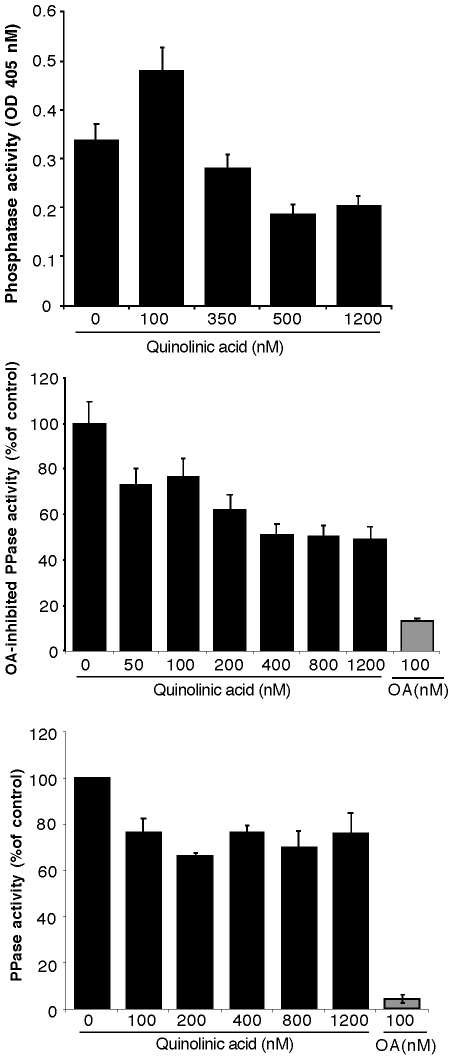
QA treatment reduces total phosphatase and PP2A activity in cultured neurons:Neuronal cultures were treated with the concentrations of QA shown, for 72 hours. Cells were lysed in the phosphatase activity buffer (50 mM Tris, pH 7.5, 150 mM NaCl, 1% NP-40, 1 mM PMSF, 1 mM Benzamidine, 10 mM β-mercaptoethanol (βME), 2 µg/ml aprotinin, 2 µg/ml pepstatin and5 µg/ml leupeptin. A: Total phosphatase activity was determined using pNPP (10 mM) as a substrate in 50 mM Tris-HCl, pH 7.4, 0.1 mg/ml BSA, 3 mM CaCl2, 1 µM calmodulin and 3 mM MnCl2. The reaction mixture was incubated at 30°C for 30 min and the absorbance measured at 405 nm. Data shown are the average (±SD) of three experiments. B: OA-inhibited (PP2A) in the lysate of neurons treated with QA. Total phosphatase activity towards pNPP was determined as above in the presence or absence of 10 nM OA. The difference in the activity lost due the addition of 10 nM OA was calculated as PP2A activity. C: Activity of immunoprecipitated PP2A towards pNPP. PP2A was immunoprecipitated from 400 µg lysate protein with anti-PP2A (clone 1D6). 20 µl of bead were resuspended in 200 µl of phosphatase activity buffer containing 50 mM Tris-HCl, pH 7.4, 3 mM MnCl2 and 10 mM pNPP. The reaction mixture was incubated at 30°C for 30 min with occasional mixing. Beads were removed and the OD of the clear supernatant was measured at 405 nm. Data from three separate experiments are shown as mean (±SD).